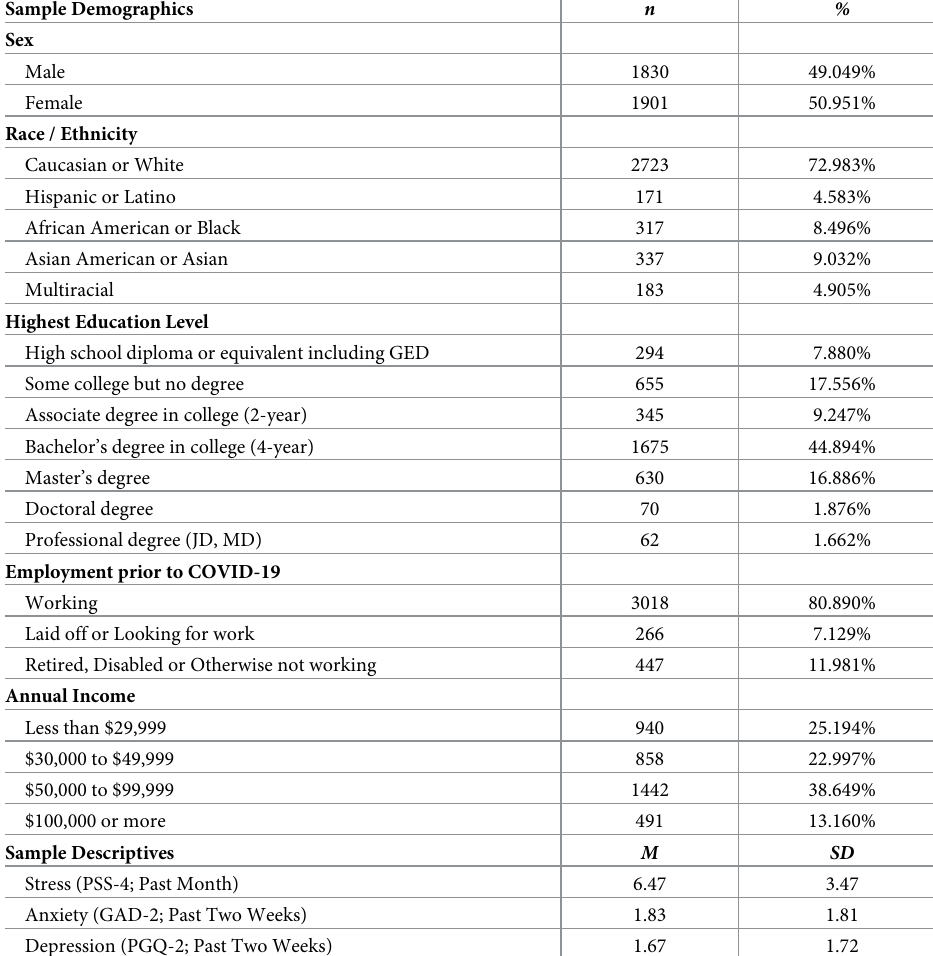
Table 1. Sample demographics and descriptives statistics for mental health